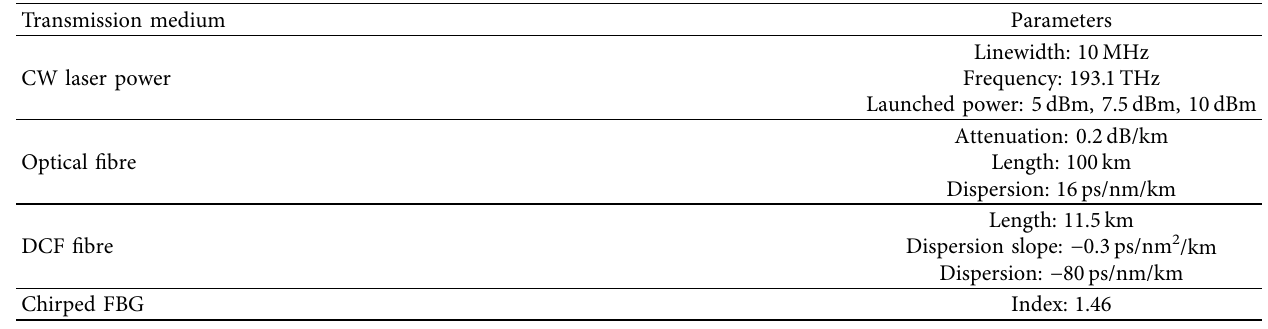
Table 1: Parameters used in simulation.